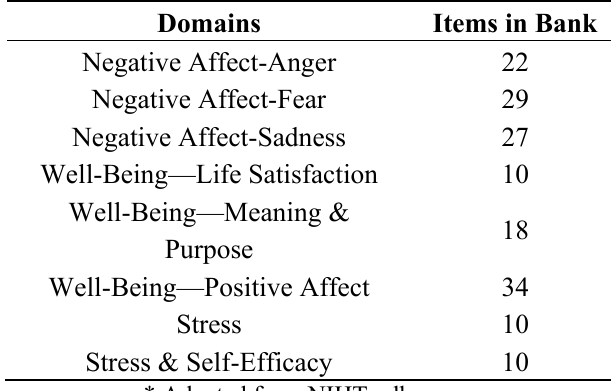
Table 2. * NIH Toolbox